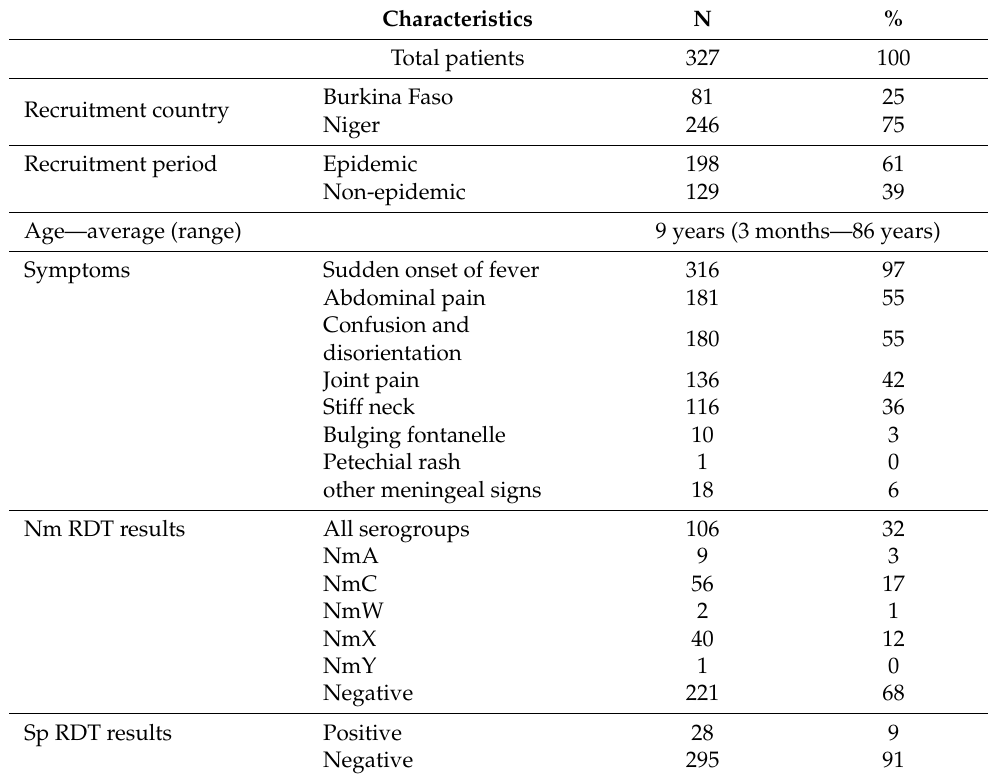
Table 1. Characteristics and distribution of symptoms among suspected cases (N = 327), Niger and Burkina Faso,